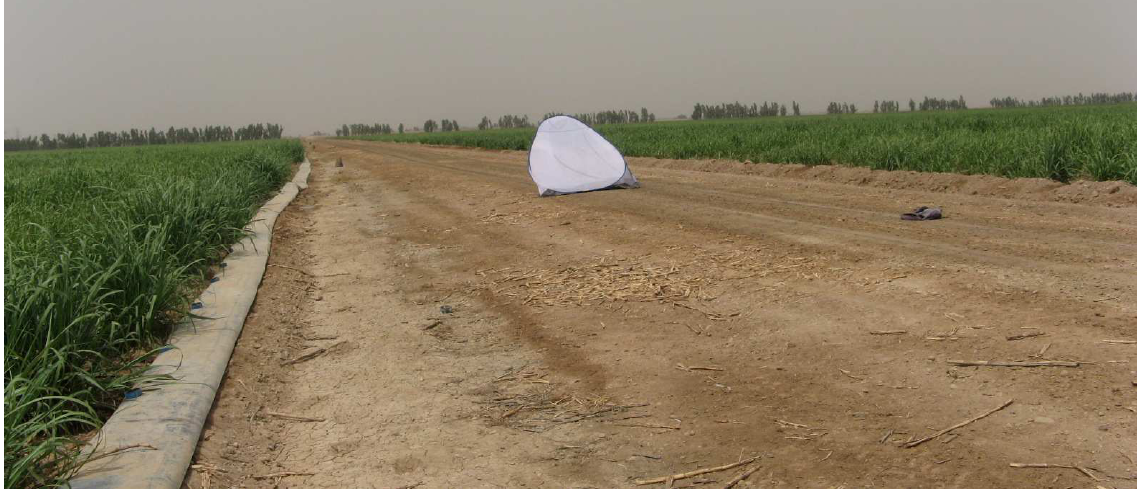
F IGURE 3. Sampling site of Hadula vassilinini in sugarcane fields of south-west Iran (the